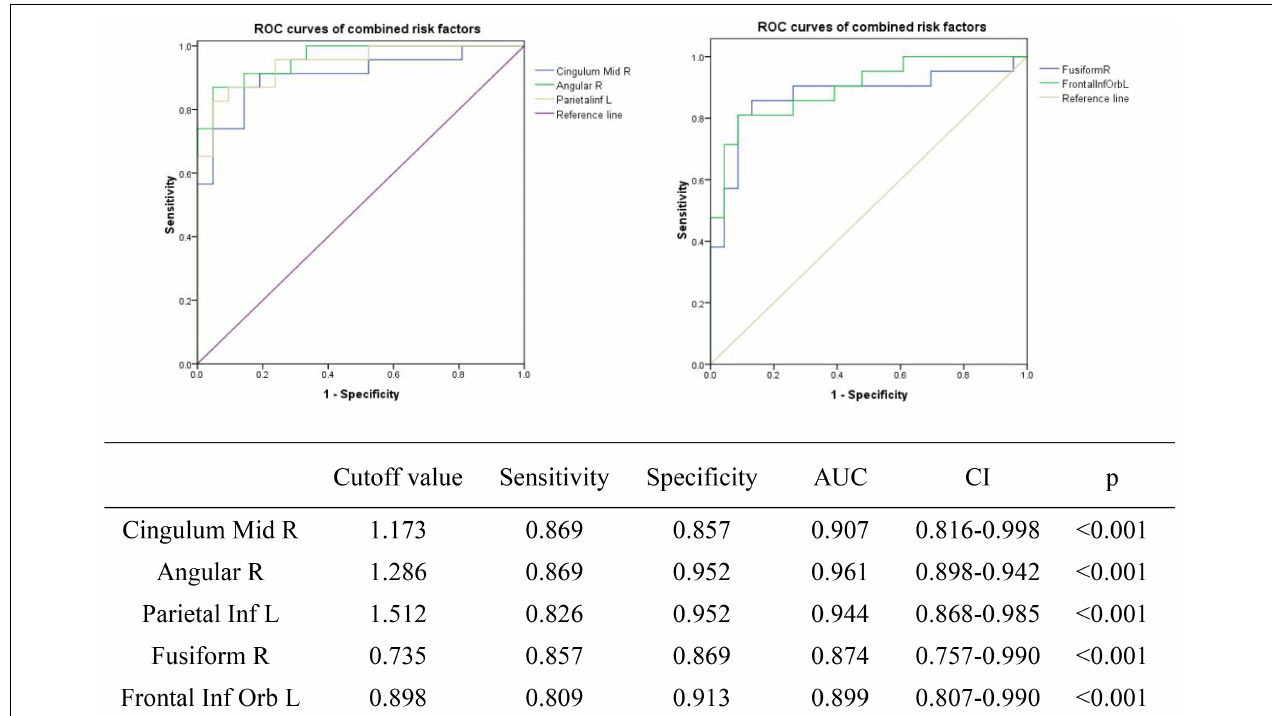
FIGURE 7 | ROC curve analysis of the mean ALFF values of the affected brain regions in SA patients. ROC, receiver operating characteristic; AUC, area under the curve; CI, confidence interval; ROC, receiver operating characteristic; ALFF, amplitude of low-frequency fluctuation.